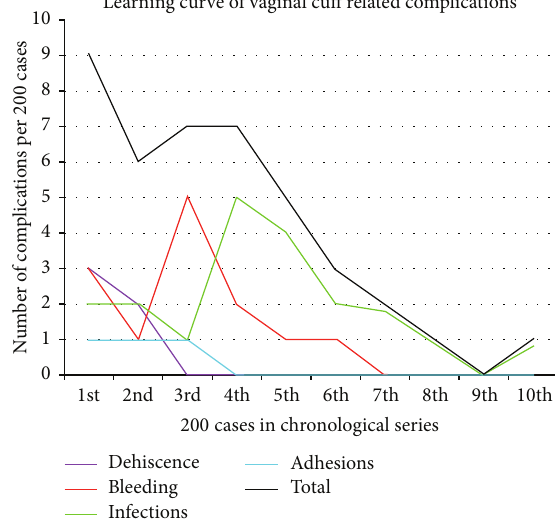
Figure 6: This chart reflects the complications separated in seg- ments of 200 cases each, over the 19 years of this study. Dehiscence (purple), bleeding (red), infections (green), and adhesions (blue) showgradualdecreaseovertime.Thetotaldecreaseincomplications (black) is due to a variety of factors including the surgeons’ learning curve, improved surgical skills, experience, and